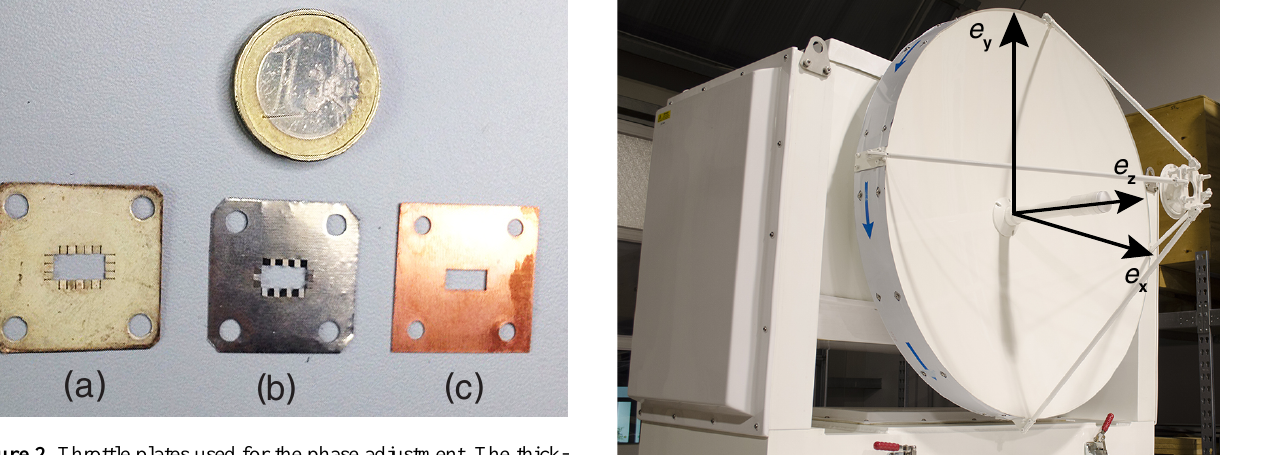
Figure 2. Throttle plates used for the phase adjustment. The thick- ness of the plates is 0.05mm (a) , 0.1mm (b) , and 0.28mm (c) . The introduced phase shift is 1 . 8 ◦ (a) , 3 . 4 ◦ (b) , and 9 . 1 ◦ (c) .